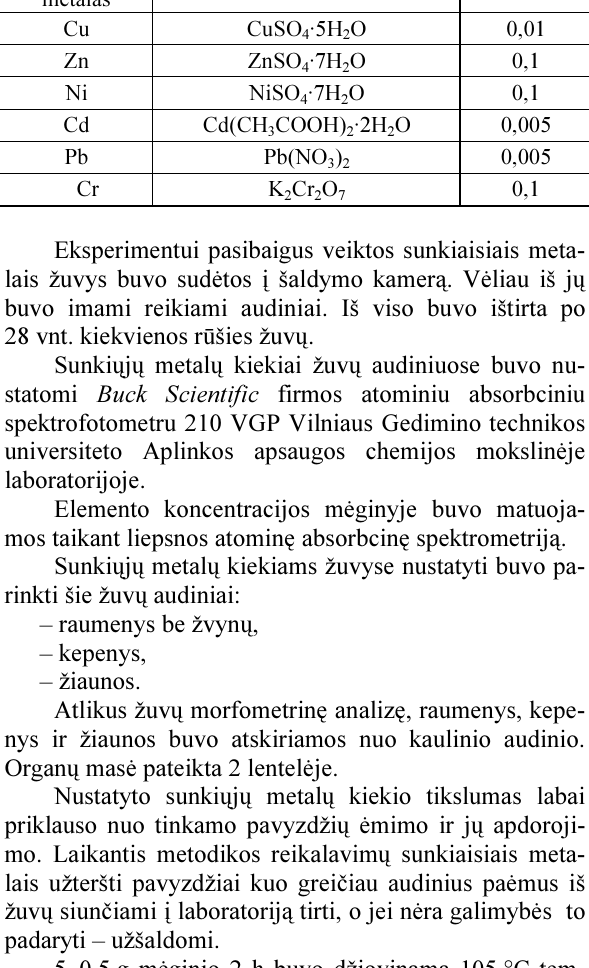
Fig. 3. Heavy metal concentrations (mg/kg) in fish tissues from water contaminated with copper in natural living condition in